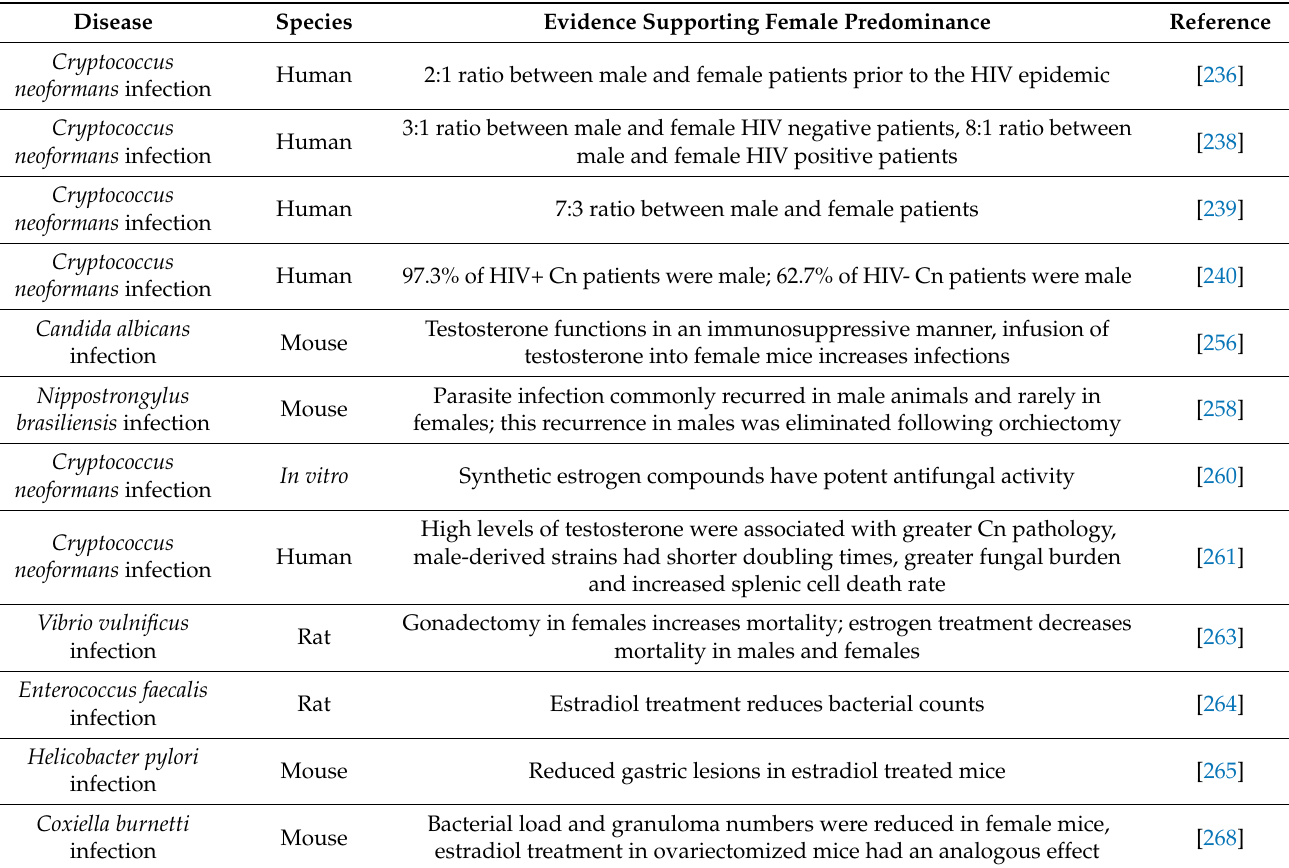
Table 4. Males are more susceptible to infections than